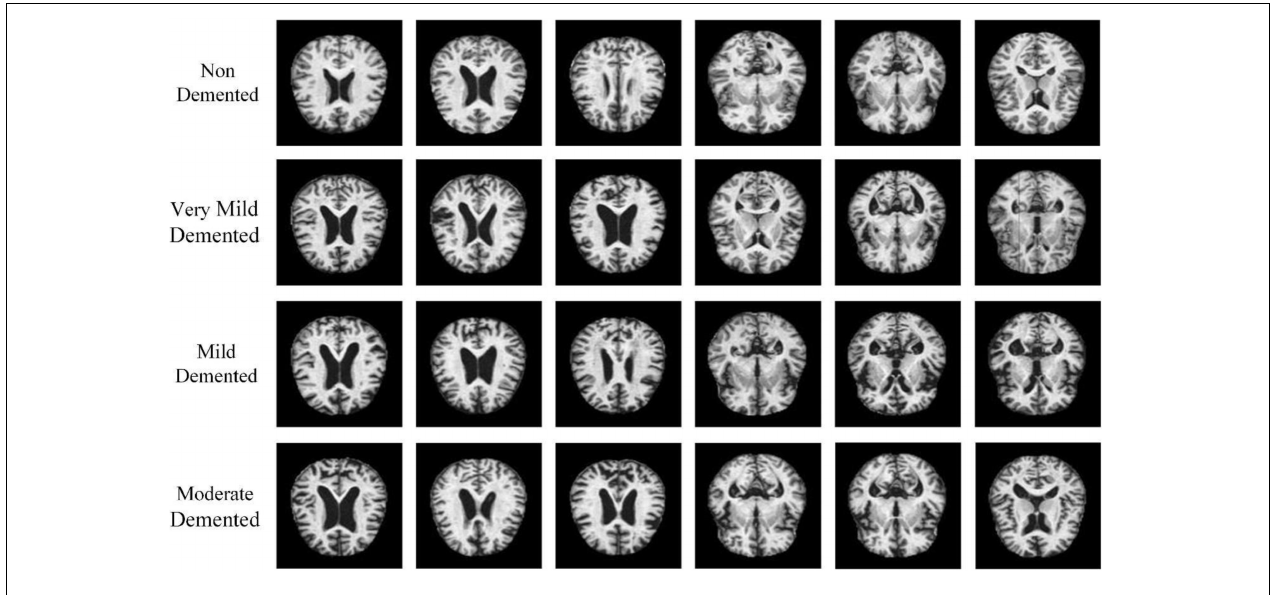
FIGURE 1 | Principles of Alzheimer’s disease recognition.